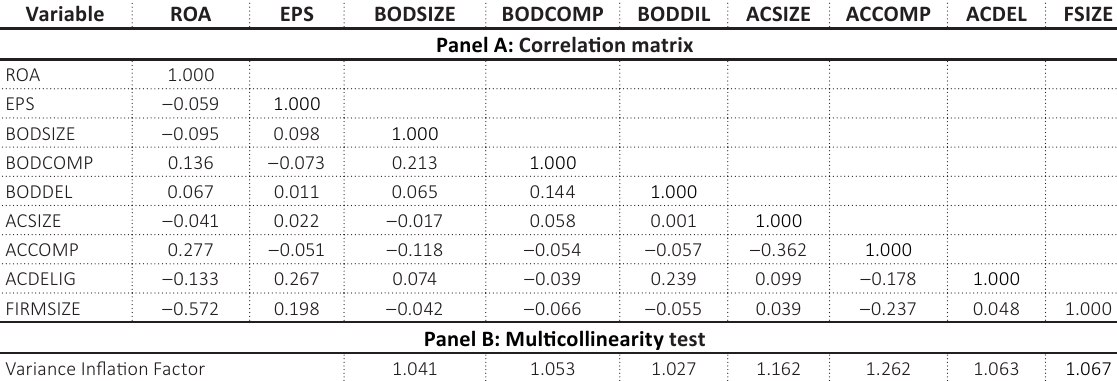
Table 3. Correlation matrix and multicollinearity test